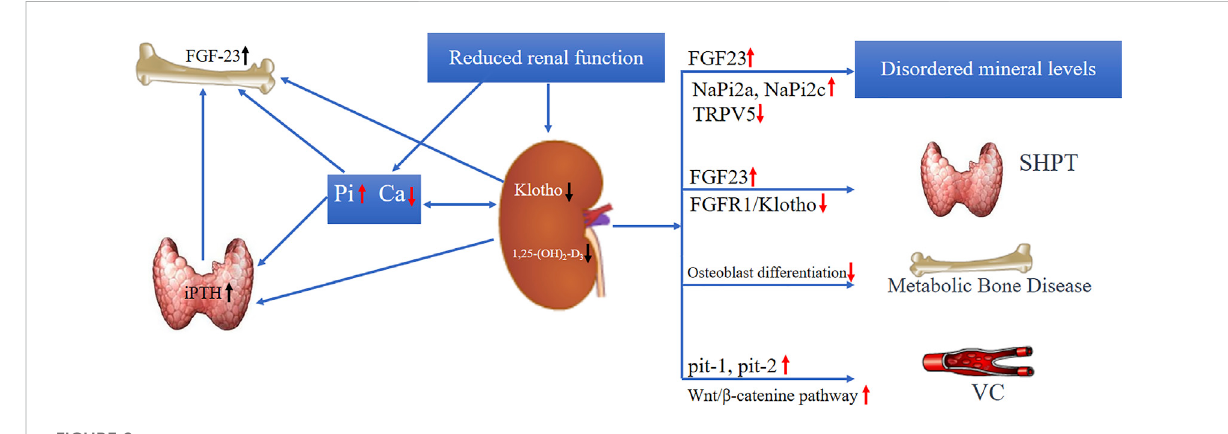
FIGURE 2 The role of Klotho in